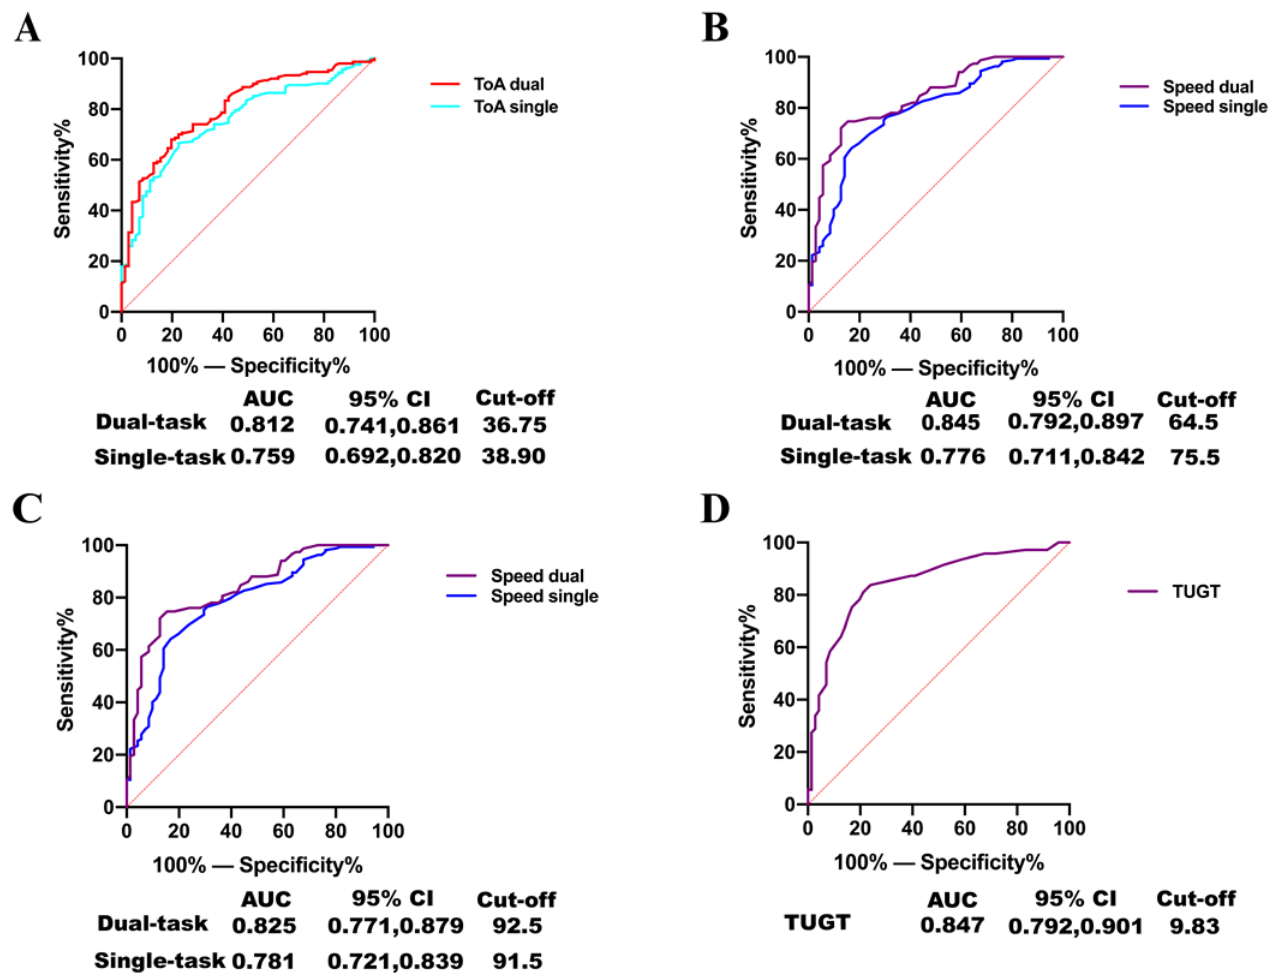
Figure 2. Gait indicators classifiers for cognitive normality and impaired diagnosis. ROC curves show the independent accuracy of gait indicators classifier disease diagnosis: ROC curve for TOA ( A ), speed ( B ), stride length ( C ), and TUGT ( D ), respectively. Abbreviations: ROC, receiver operating characteristic; OR, odds ratio; CI, confidence interval; AUC, area under the roc curve; TOA, toe-off ground angle; TUGT, timed “Up & Go” time.